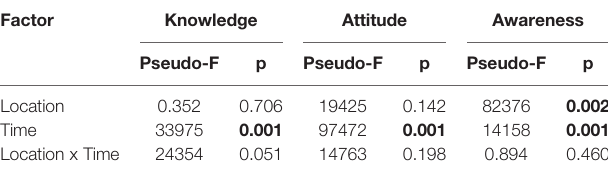
TABLE 2 | PERMANOVA a,b analyses testing the effect of factors location and time on sustainability variables (knowledge, attitude, awareness). Factor